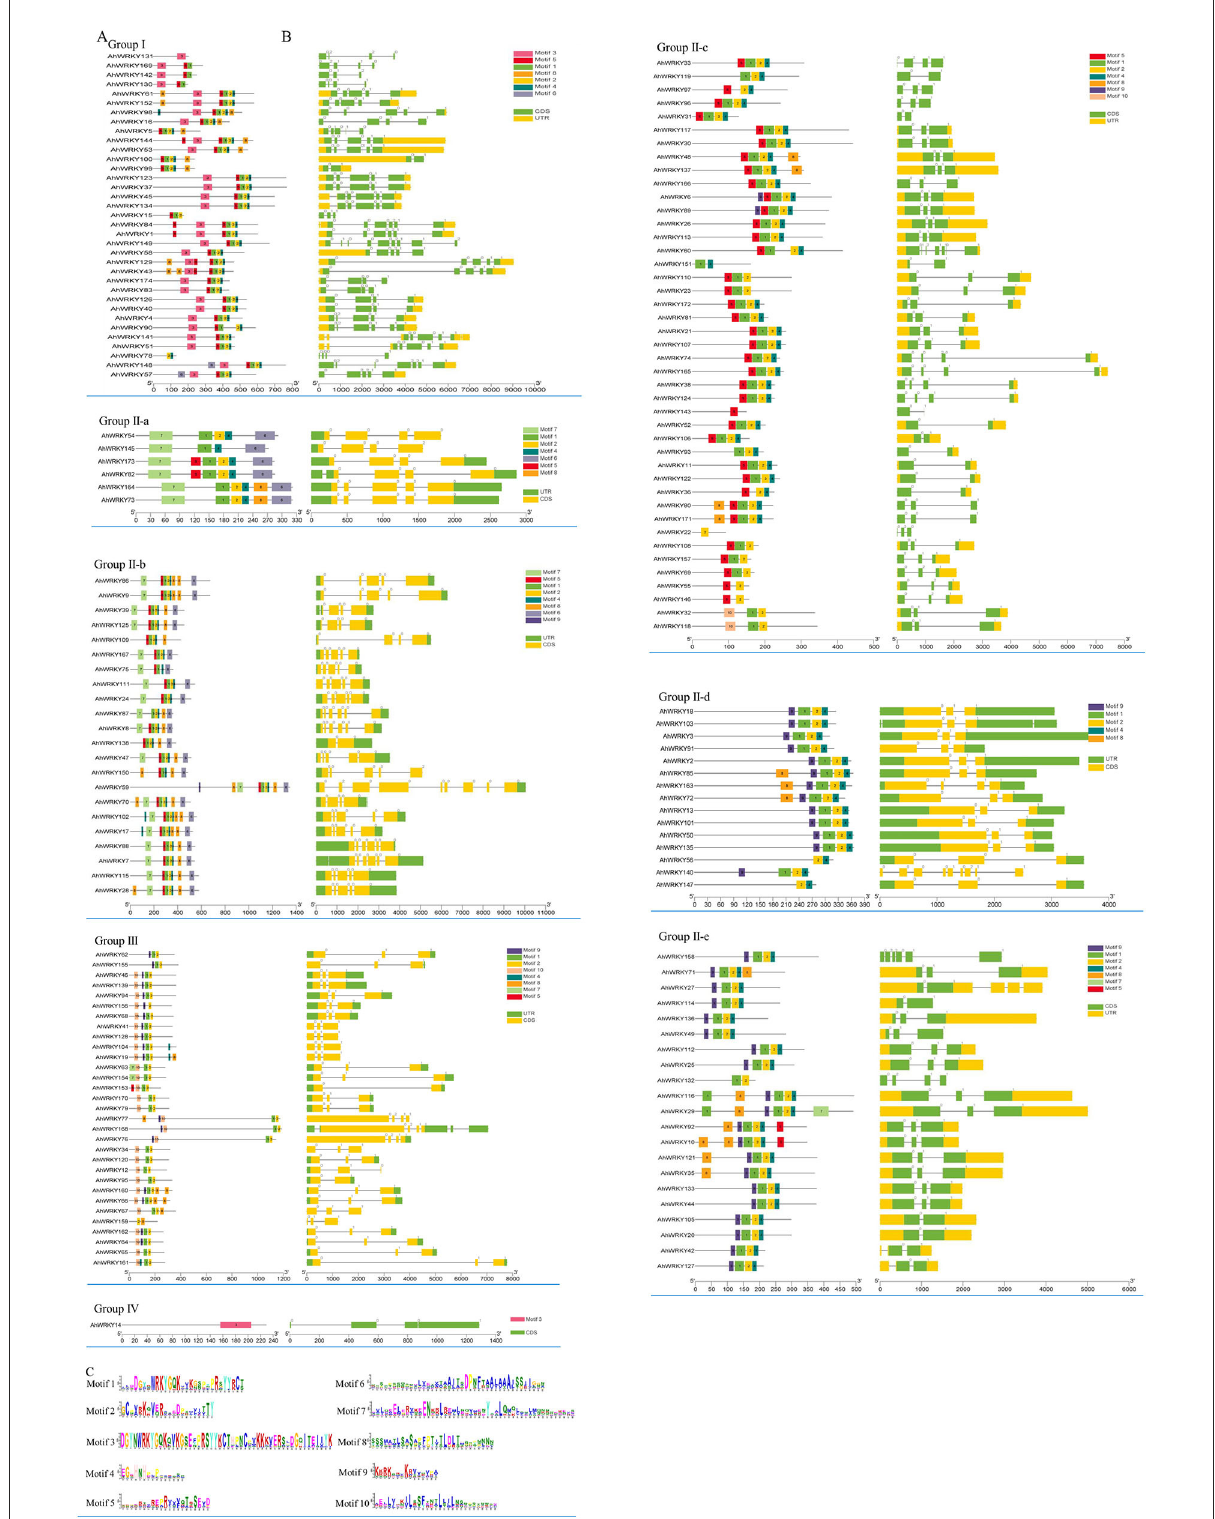
FIGURE4 Gene structures and conserved motif analysis of AhWRKY genes. (A) The conserved motif of AhWRKY. (B) The exon–intron structure of AhWRKY. (C) The amino acid composition of each motif. Each conserved motif is represented by various-colored rectangles. Box length corresponds to motif length. Different colors represent different group members. Due to the large image size, we have presented the structures and motifs in various